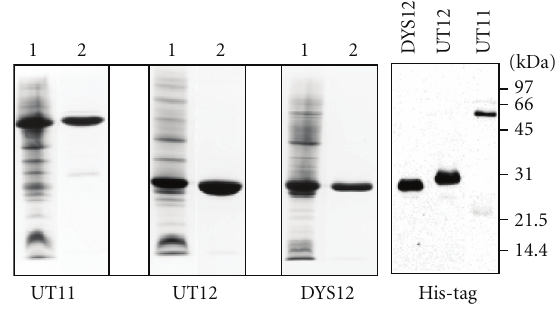
Figure 4: Expression and purification of the recombinant utrophin (UT11 and UT12) and dystrophin (DYS12) fragments used for in vitro actin-binding studies. Fragments were expressed in E. coli by induction with isopropyl- β -D-1-thiogalactopyranoside (IPTG), subsequently purified by Ni-NTA (Ni-nitrilotriacetic acid) a ffi nity chromatography, and finally checked on 10% SDS-PAGE. Protein staining with Coomassie brilliant blue R250 of bacterial expression (lanes 1) and purified fragments (lanes 2). The fragments were also immunostained with an anti-His-tag